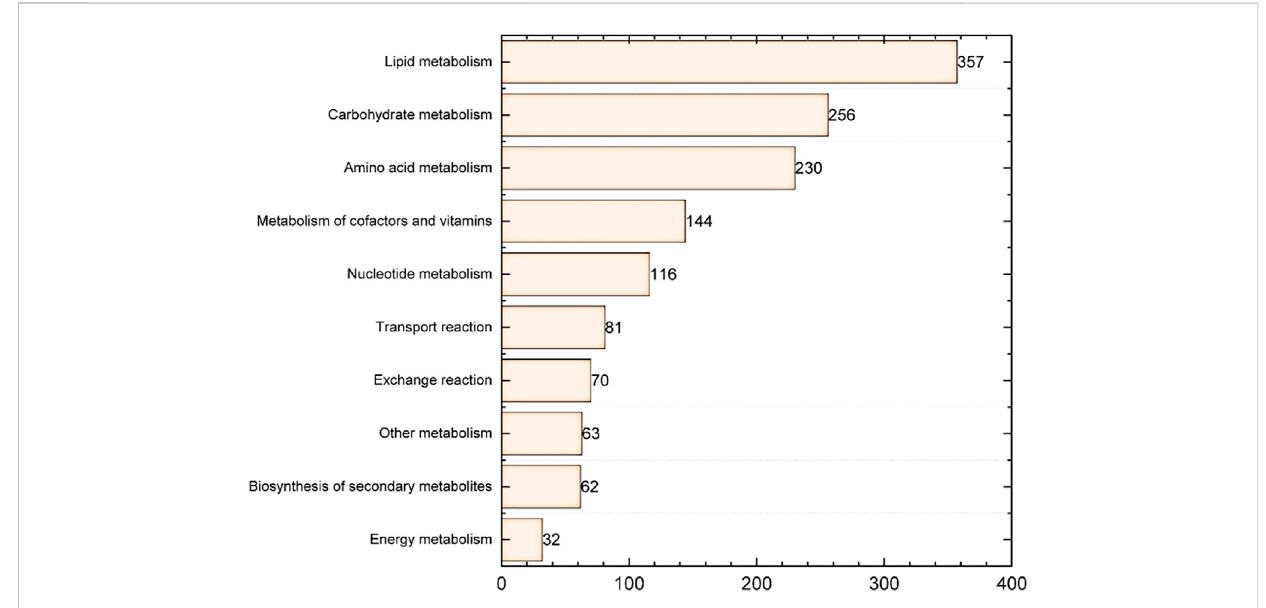
FIGURE 1 The response distribution of the metabolic subsystem in model i